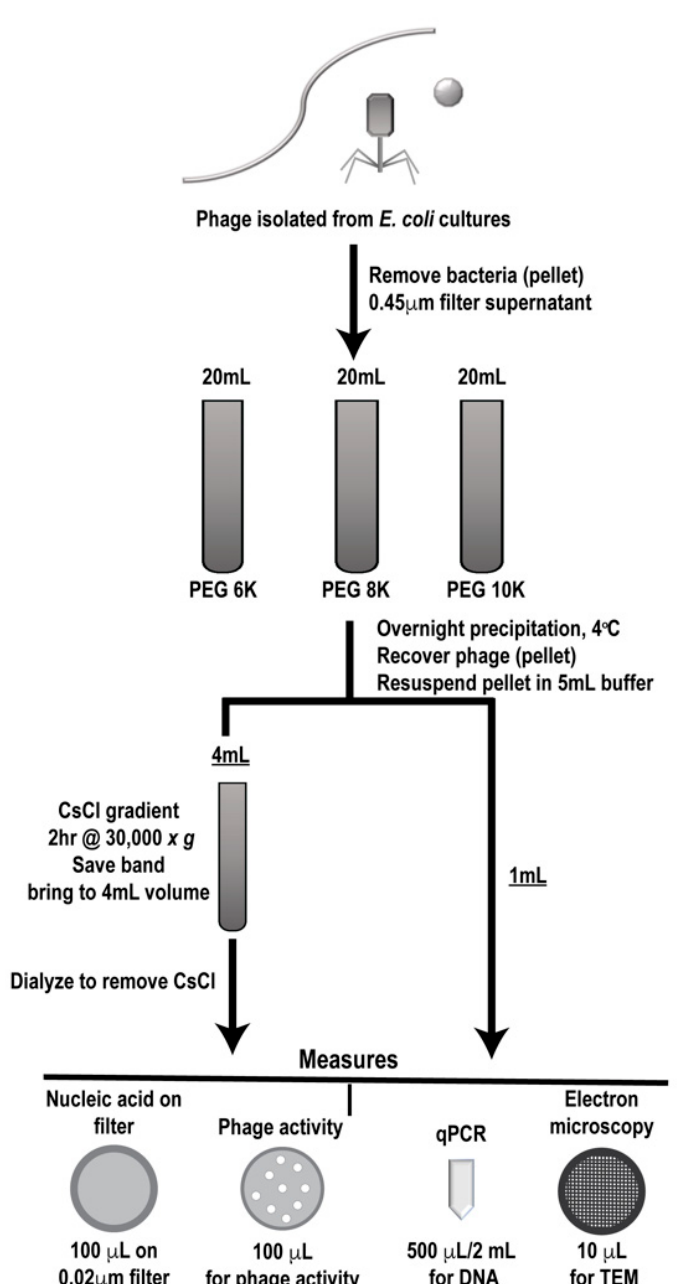
Figure 2. Work flow for phage preparation. Outline of phage preparation procedure showing where collection points occurred, purification steps taken (polyethylene glycol (PEG) precipitation followed by cesium chloride (CsCl) gradient purification) and types of analyses used